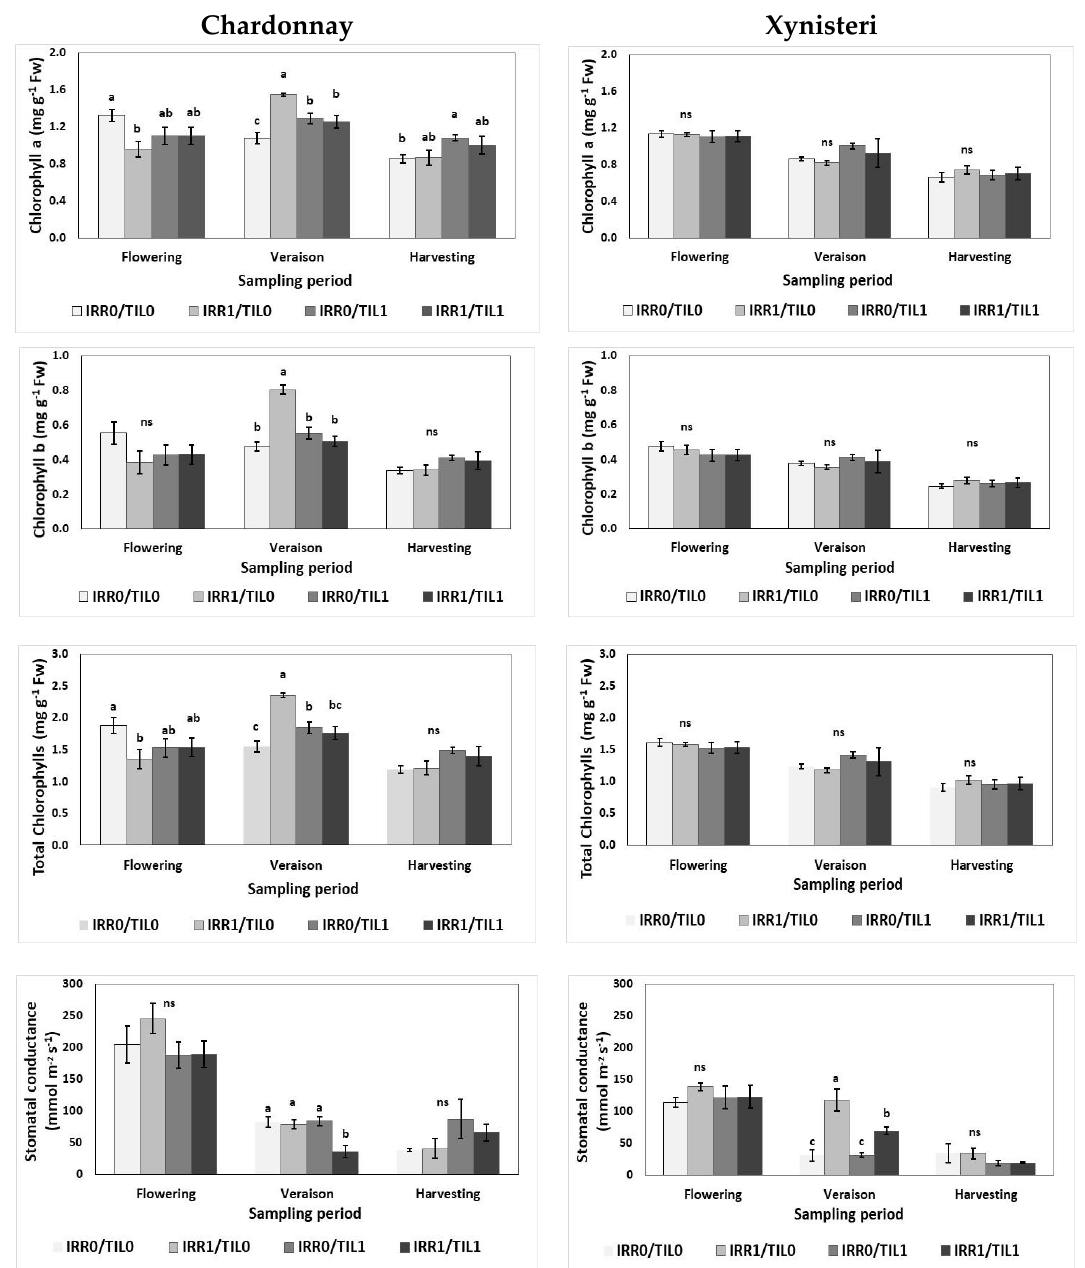
Figure 2. Impact of irrigation and tillage on Chlorophyll a (Chl a; mg g −1 Fw), Chlorophyll b (Chl b; mg g −1 Fw), total chlorophylls (total Chl; mg g −1 Fw) and leaf stomatal conductance (mmol m −2 s −1 ). Sampling dates were during flowering (1st sampling), veraison (2nd sampling) and harvesting (3rd sampling). Significant differences ( p < 0.05) among treatments are indicated by different letters according to Duncan’s multiple range tests. Error bars show SE ( n = 4). ns: not significant.